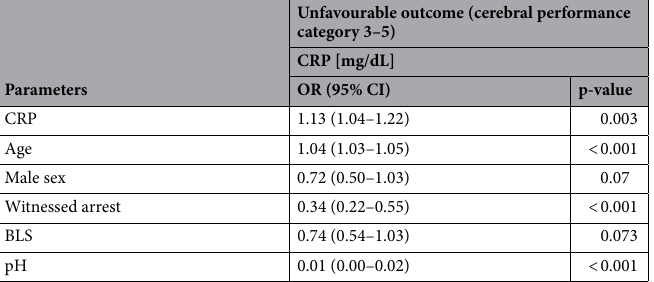
Table 2. Multivariate analysis of the primary endpoint (n = 832). Unfavourable outcome was analysed by binary logistic regression using a backward stepwise elimination approach according to Wald test statistic step- by-step. The presented parameters are the ones remaining in the final step of the model. BLS basic life support, CI confidence interval, CRP C-reactive protein, OR odds ratio.